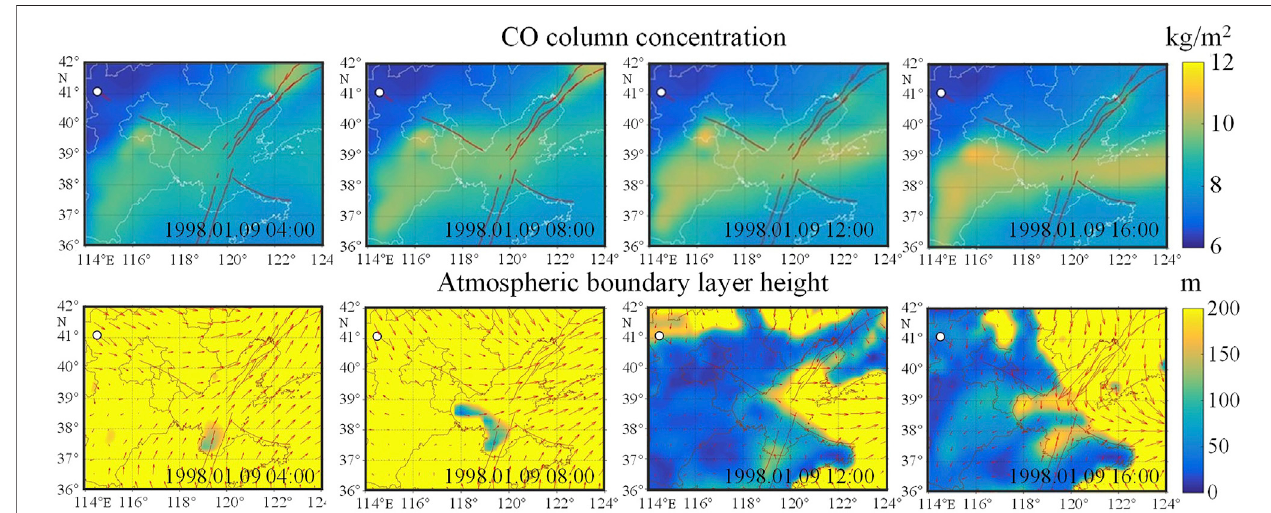
FIGURE 13 | The atmospheric boundary layer height and the CO column concentration on 9 January